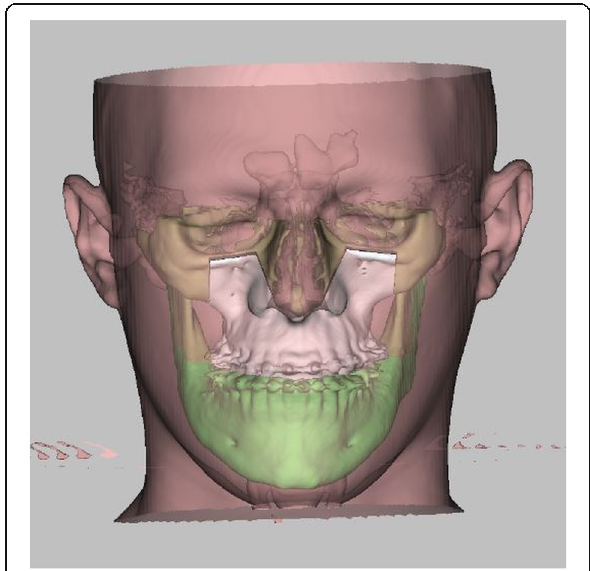
Fig. 4 Simulation of the treatment result with transparent overlaying soft tissue in Dolphin Imaging